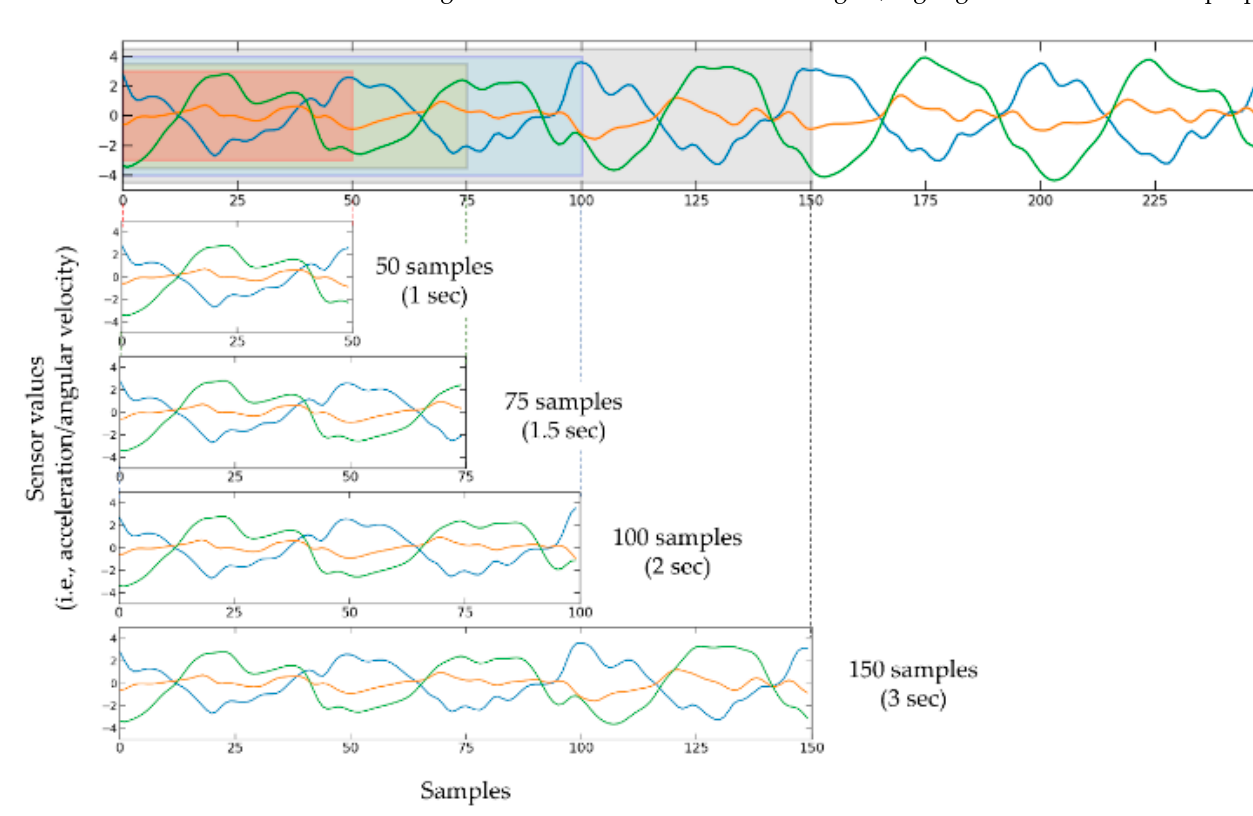
Figure 4. Example process of segmenting the raw measurements with different segmenting windows, highlighted for visualization purposes. Noting that inertial signals have periodic characteristics, the input 6-axis raw signals were partitioned into data segments (L × 6) with four different fixed-lengths of signals (L = 50, 75, 100, and 150 samples, each of which corresponds to approximately 1.0, 1.5, 2.0, and 3.0 s) for investigating the effective signal length of running and walking activities. Note that the beginning and end of a cycle of repetitive motion are not aligned with a segmenting window so that an arbitrary part of raw measurements can be segmented.